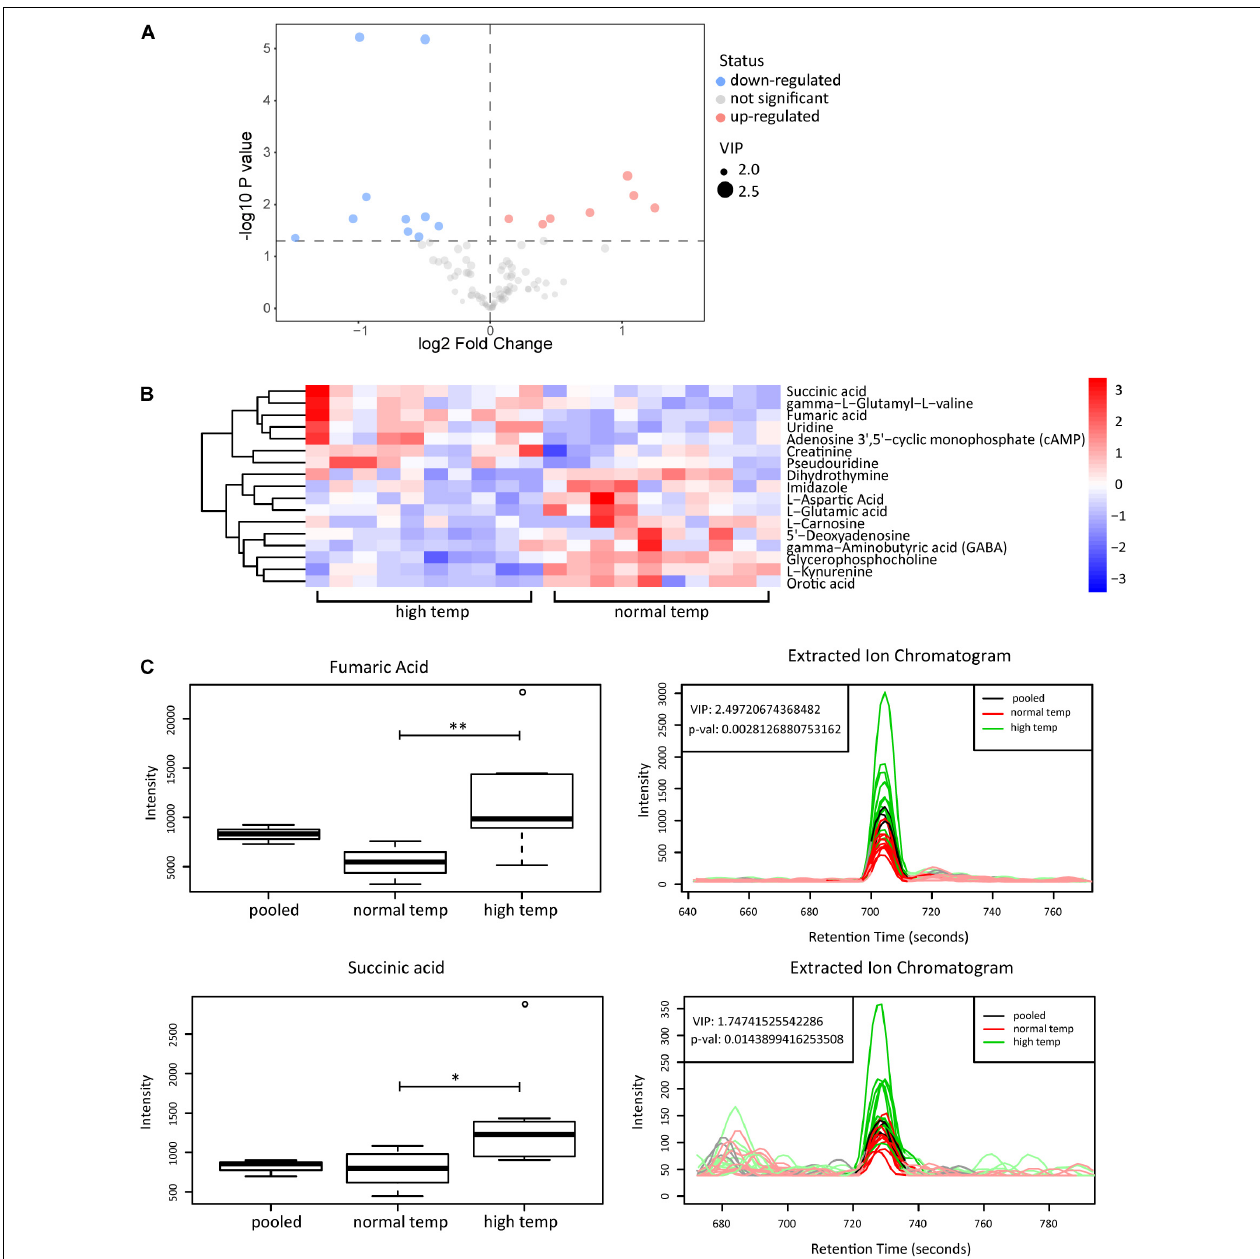
FIGURE 4 | Metabolomic analyses of plasma from EAU mice housed in normal or high temperature conditions. (A) The upregulated (red) and downregulated (blue) metabolites between the high and normal temperature group are shown in the volcano plots. (B) Heatmap of the 17 significantly differential metabolites. The color is positively correlated with the intensity of change in metabolites, with red indicating up-regulation and blue indicating down-regulation. (C) The response of fumaric acid and succinic acid in the sample (left) and extracted ion chromatogram (right) between the high (green) and normal temperature (red) group. The relative quantitative results and extracted ion chromatogram are shown. Pooled represents the quality control sample ( n = 10/group; ** p < 0.01, * p <